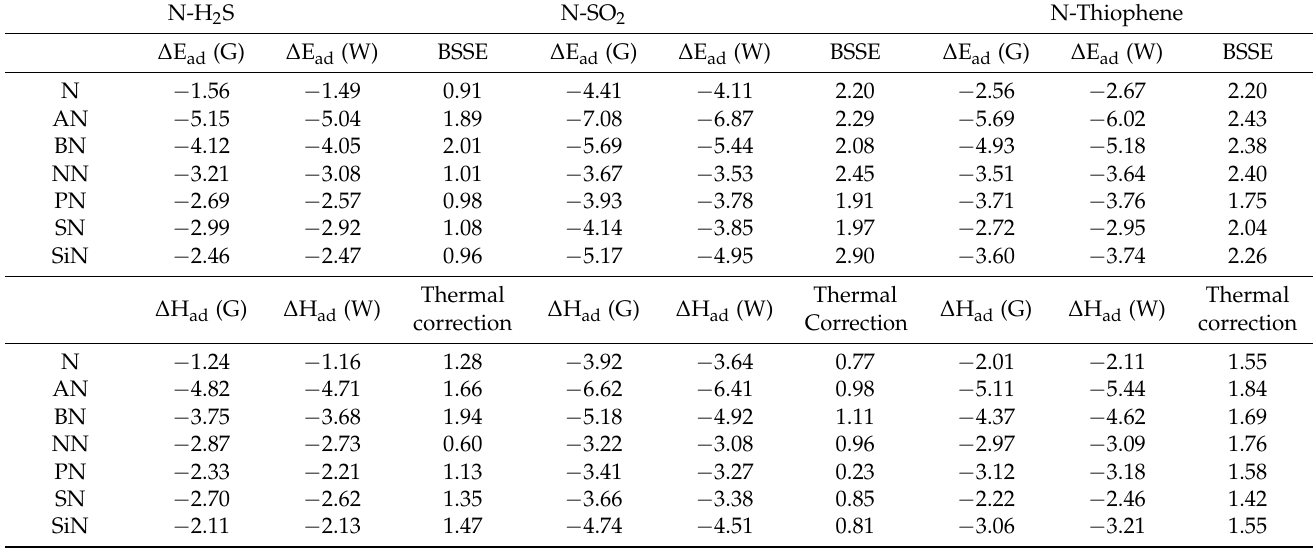
Table 2. Adsorption energies ( ∆ E ad ), thermal correction of adsorption energies, basis set superposition error (BSSE) values, enthalpies of adsorptions ( ∆ H ad ) and Gibbs free energy of adsorptions ( ∆ G ad ) of all nanostructures with H 2 S, SO 2 , and thiophene in the gas (G) and water as solvent (W). All energy values are reported in kcal/mol by considering BSSE and thermodynamics